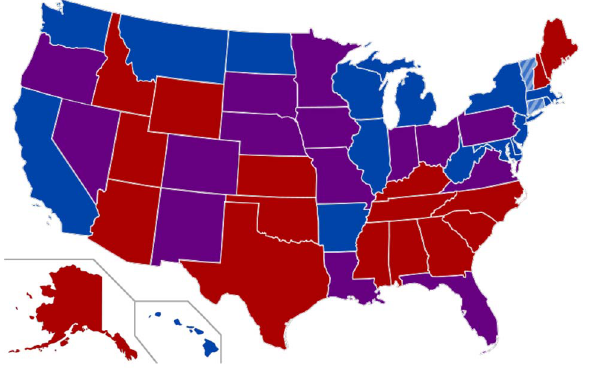
Figure 3. 110th US Congress Senate. USA map colored by the party who holds the seats in the 110th Senate (between January 3, 2007, and January 3, 2009). Blue: fully Democratic state; Red: Fully Republican state; Purple: Half Republican, half Democratic; Striped blue: Indepen- dent senator. Image taken from http://commons.wikimedia.org/wiki/ File:110th_US_Congress_Senate.svg.